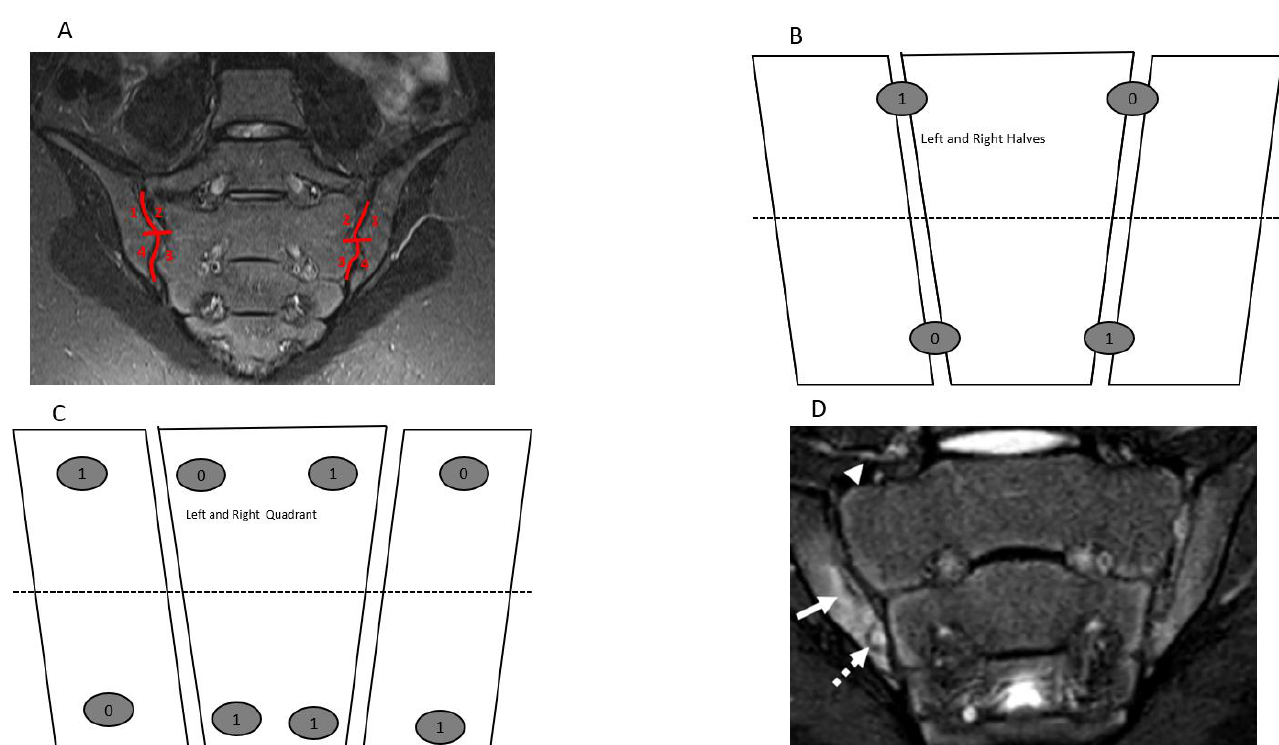
Figure 1. Semicoronal T2 Short Tau Inversion Recovery (STIR) MR images ( A , D ) and sketches ( B , C ) through the sacroiliac joint (SIJ) illustrate the measurement and method and component of the JAMRIS-SIJ. ( A ) SIJ in a 14-year-old boy shows a normal SIJ divided into quadrants by a vertical line through the joint space and a horizontal line that intersects at the mid portion of the joint (red lines) into superior iliac, sacral, inferior sacral and iliac quadrants in clockwise direction on the right and direction on the left side. ( B , C ) Corresponding schema of the SIJ, with ( B ) showing the division of the SIJ into halves and ( C ) showing the division into quadrants with a corresponding example of the scoring JAMRIS-SIJ components. ( D ) SIJ in a 12-year-old boy with enthesitis-related arthritis/juvenile spondylarthritis (ERA/JSPpA) demonstrates bone marrow edema (BME) involving the inferior aspect of the right ilium ( A —solid arrow). The intensity of the BME signal (arrow) is equal to the signal of the presacral veins. There is a bony defect in the inferior aspect of the right iliac bone seen on both T2-weighted ( A ) and T1-weighted (Figure 2D) images (dashed arrow) with associated BME, consistent with an erosion.